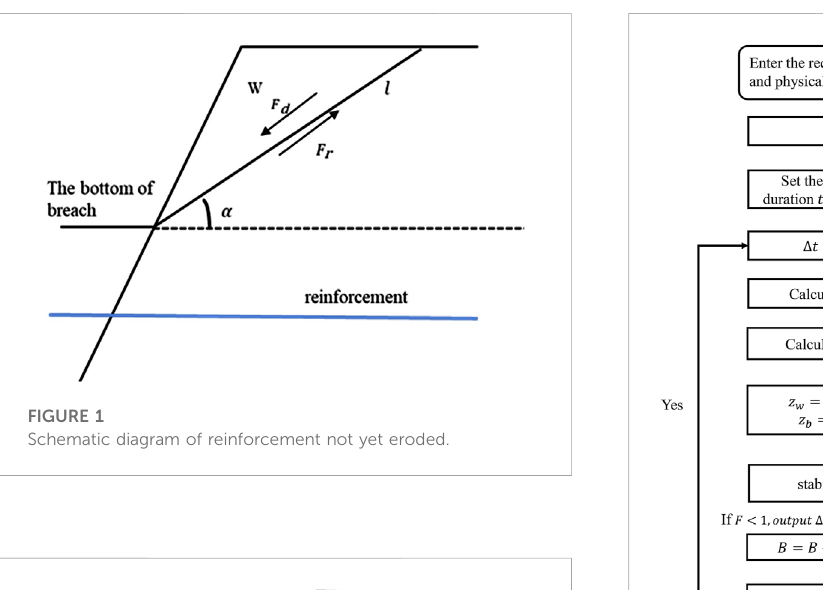
FIGURE 3 Calculation fl ow chart.